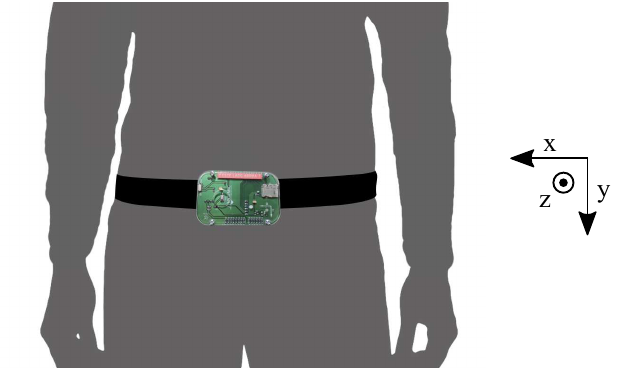
Figure 1. Device used for acquisition. The self-developed embedded device included two accelerometers and a gyroscope. It was fixed to the waist of the